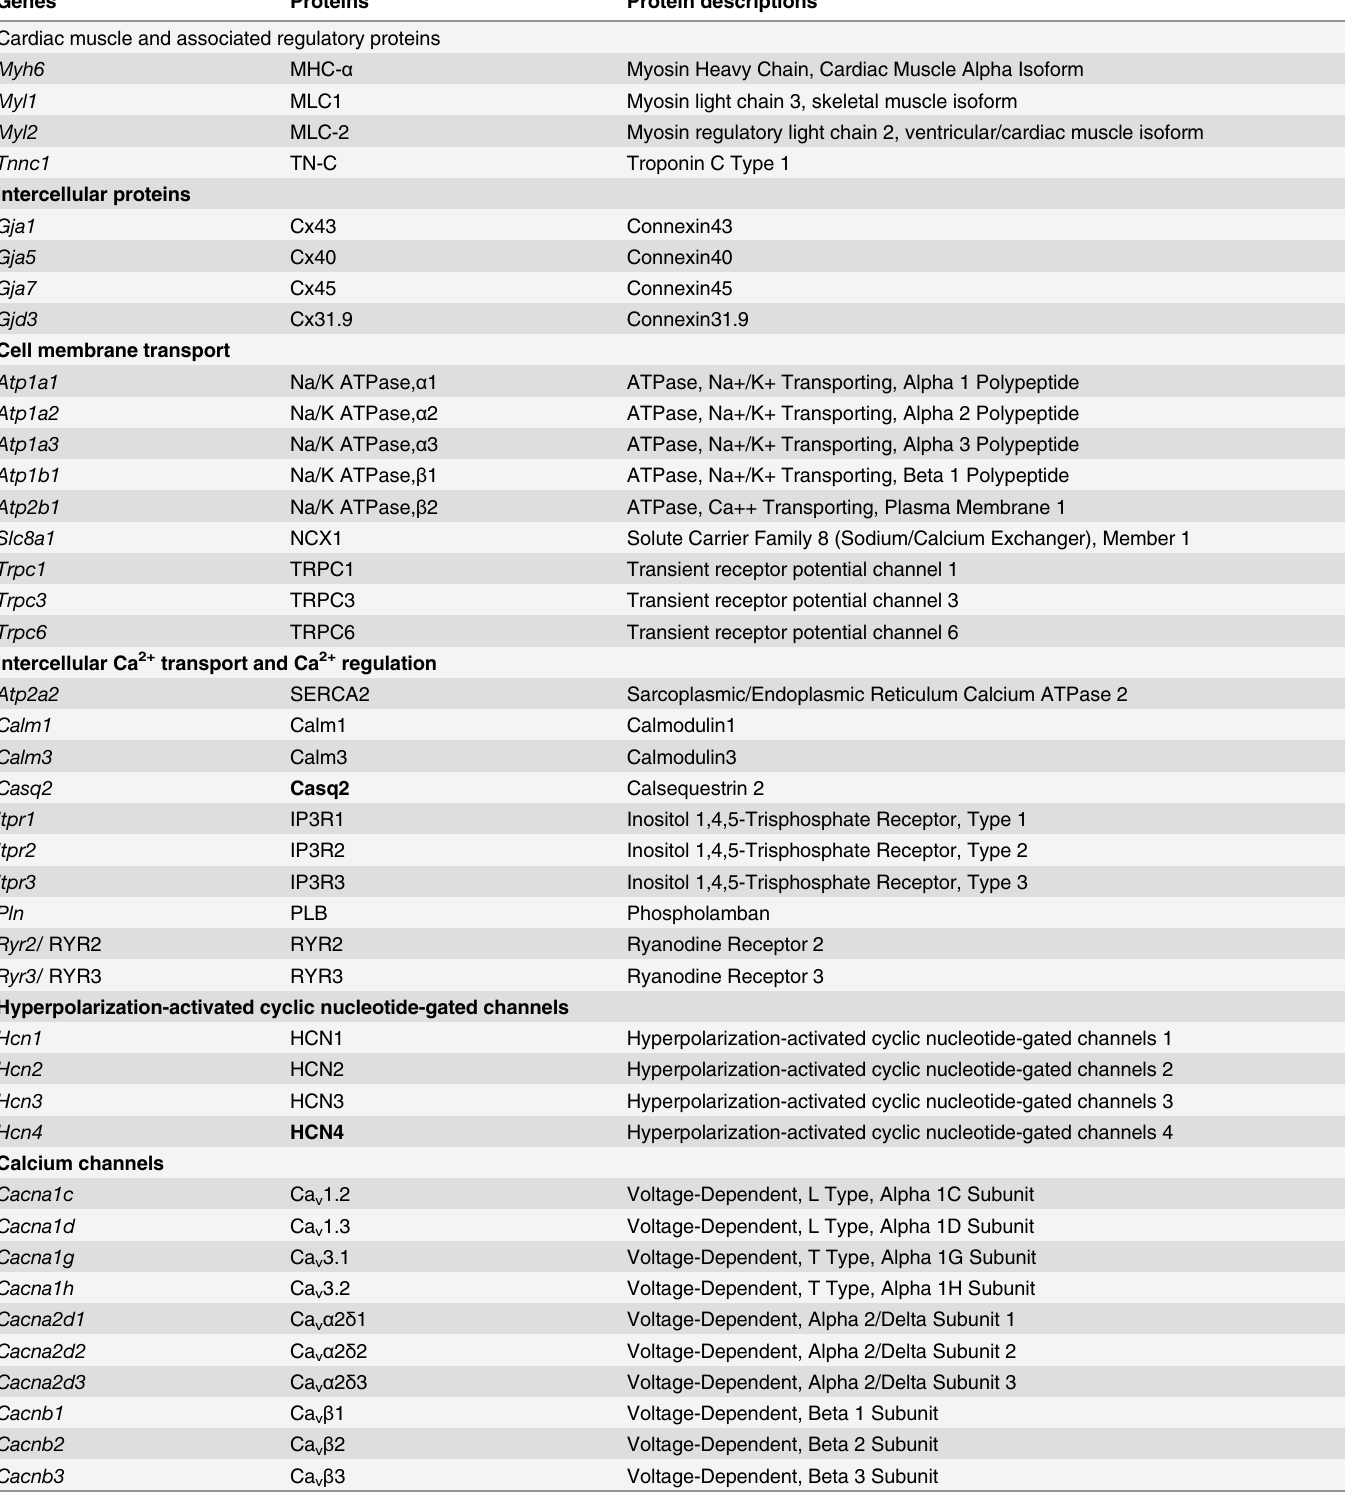
Table 1. Target genes and